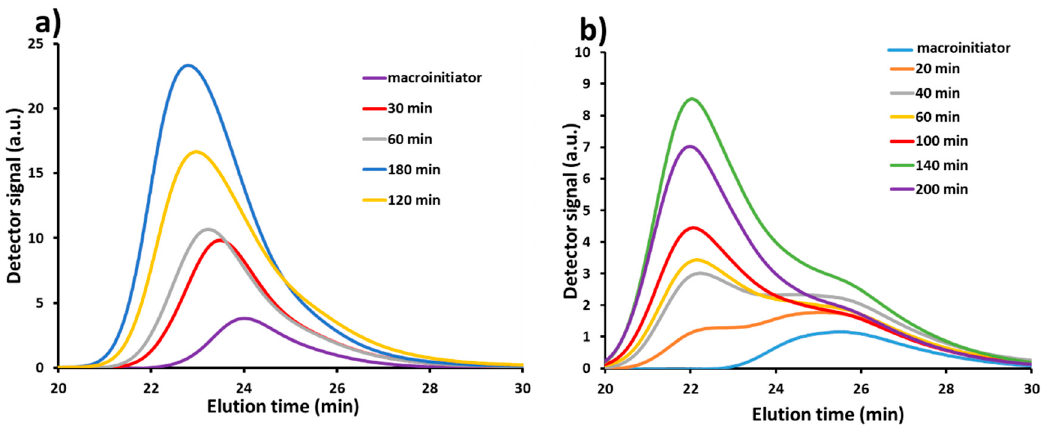
Figure 9. GPC traces (elution time) of DBI-S chain extension experiments with S at 110 °C using a macroinitiator P(DBI-S) a) f DBI,0 = 0.20 and b) f DBI,0 = 0.80. Table 5. Summary of chain extension reactions of dibutyl itaconate/styrene (DBI/S) macroinitiators with styrene at 110 °C in 50 wt% dioxane solution.